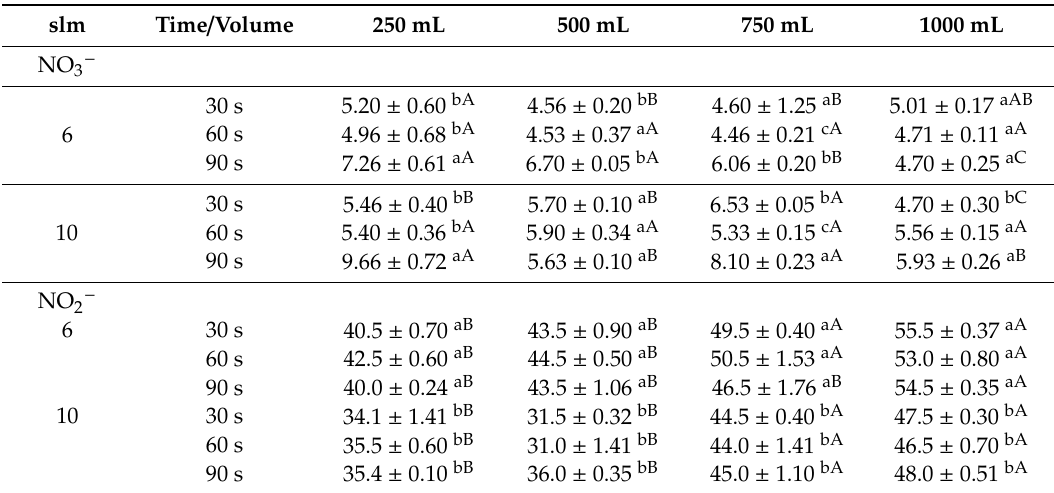
Table 7. The concentrations of nitrate (NO 3 − ) and nitrite (NO 2 − ) of the PAW generated by two plasma jets at 6 or 10 slm with di ff erent treatment times and water